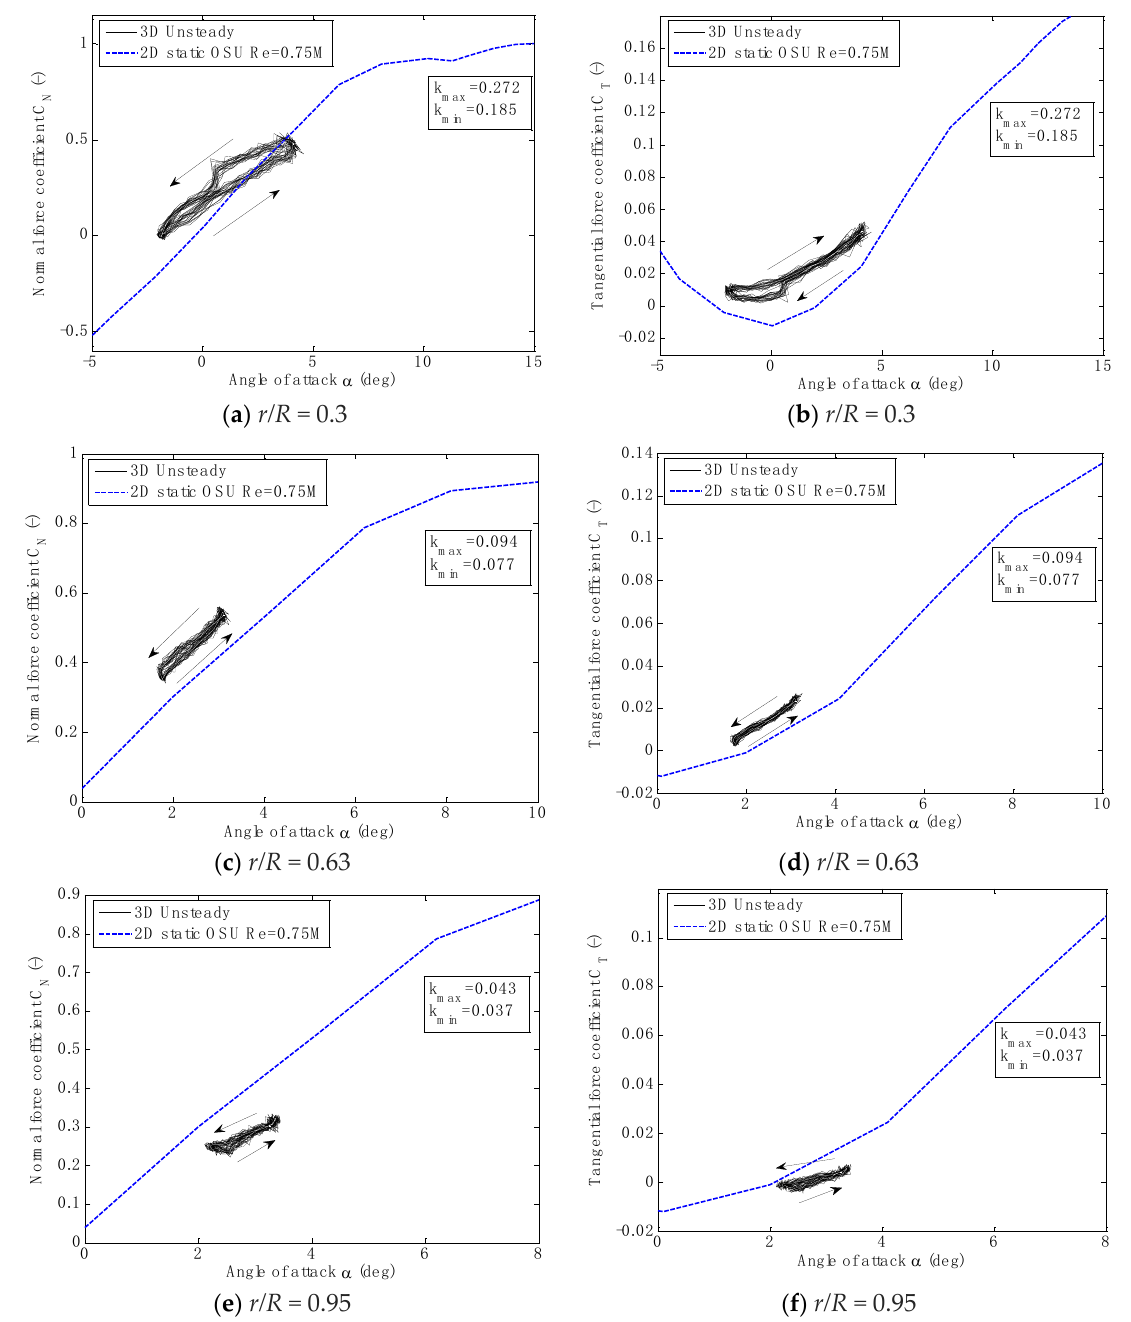
Figure 6. Variation of the unsteady normal and tangential force coefficients against angle of attack for wind speed 5 m/s and yaw angle 30°. Solid white lines denote average of C N and C T over 30 rotor rotations, while the black lines indicate the cycle-to-cycle variation in C N and C T over 30 rotor rotations.